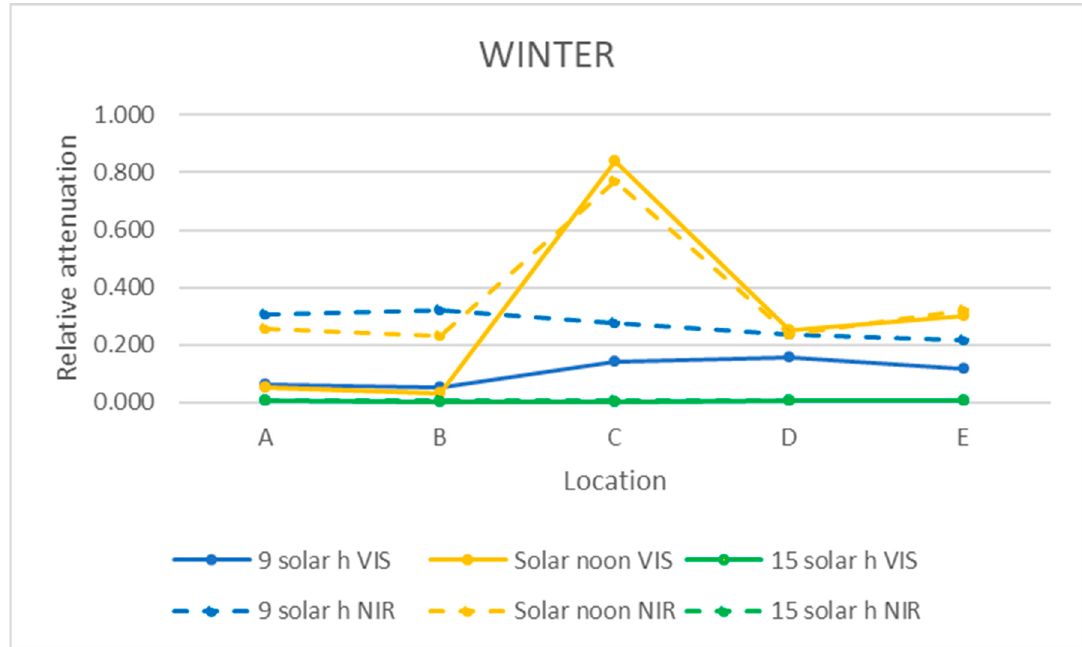
Figure 14. Representation of the mean relative attenuation for the VIS and NIR ranges for the 5 locations studied in winter at 3 times of day.